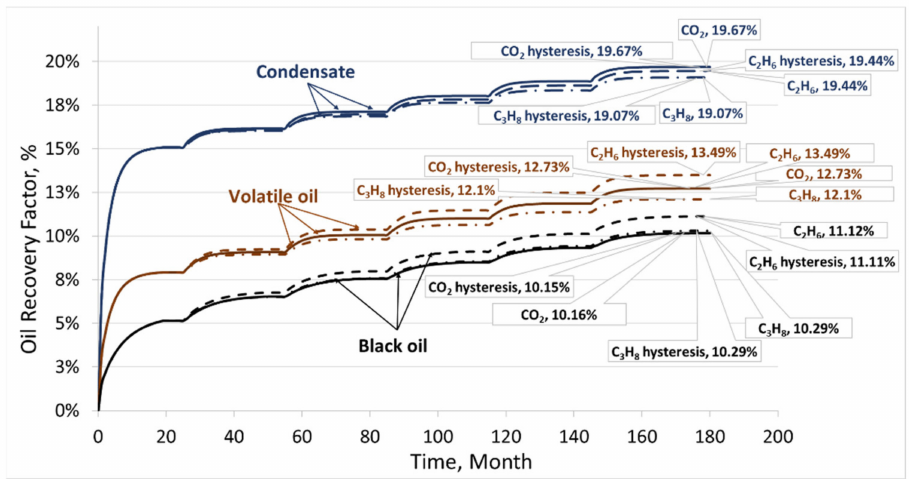
Figure 14. Hysteresis impact on the oil recovery for the condensate fluid